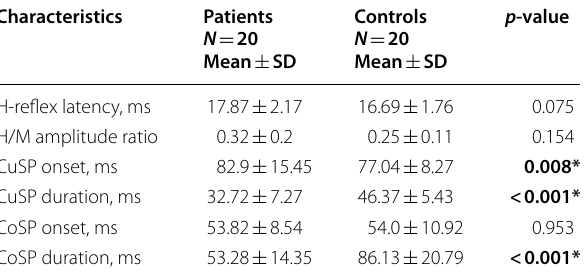
Table 3 Comparison of neurophysiological data in the study